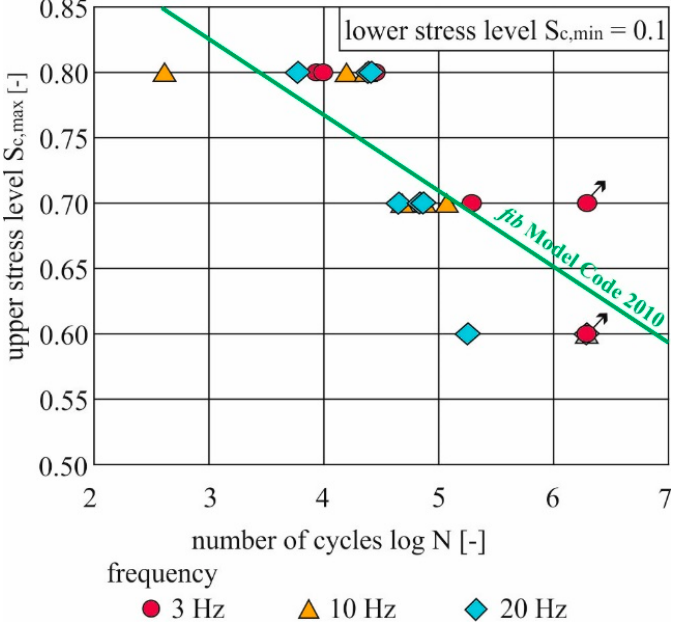
Figure 6. Comparison of the numbers of cycles to failure of the UHPC 1 specimens in relation to the Wöhler curve of the fib Model Code 2010 [20].